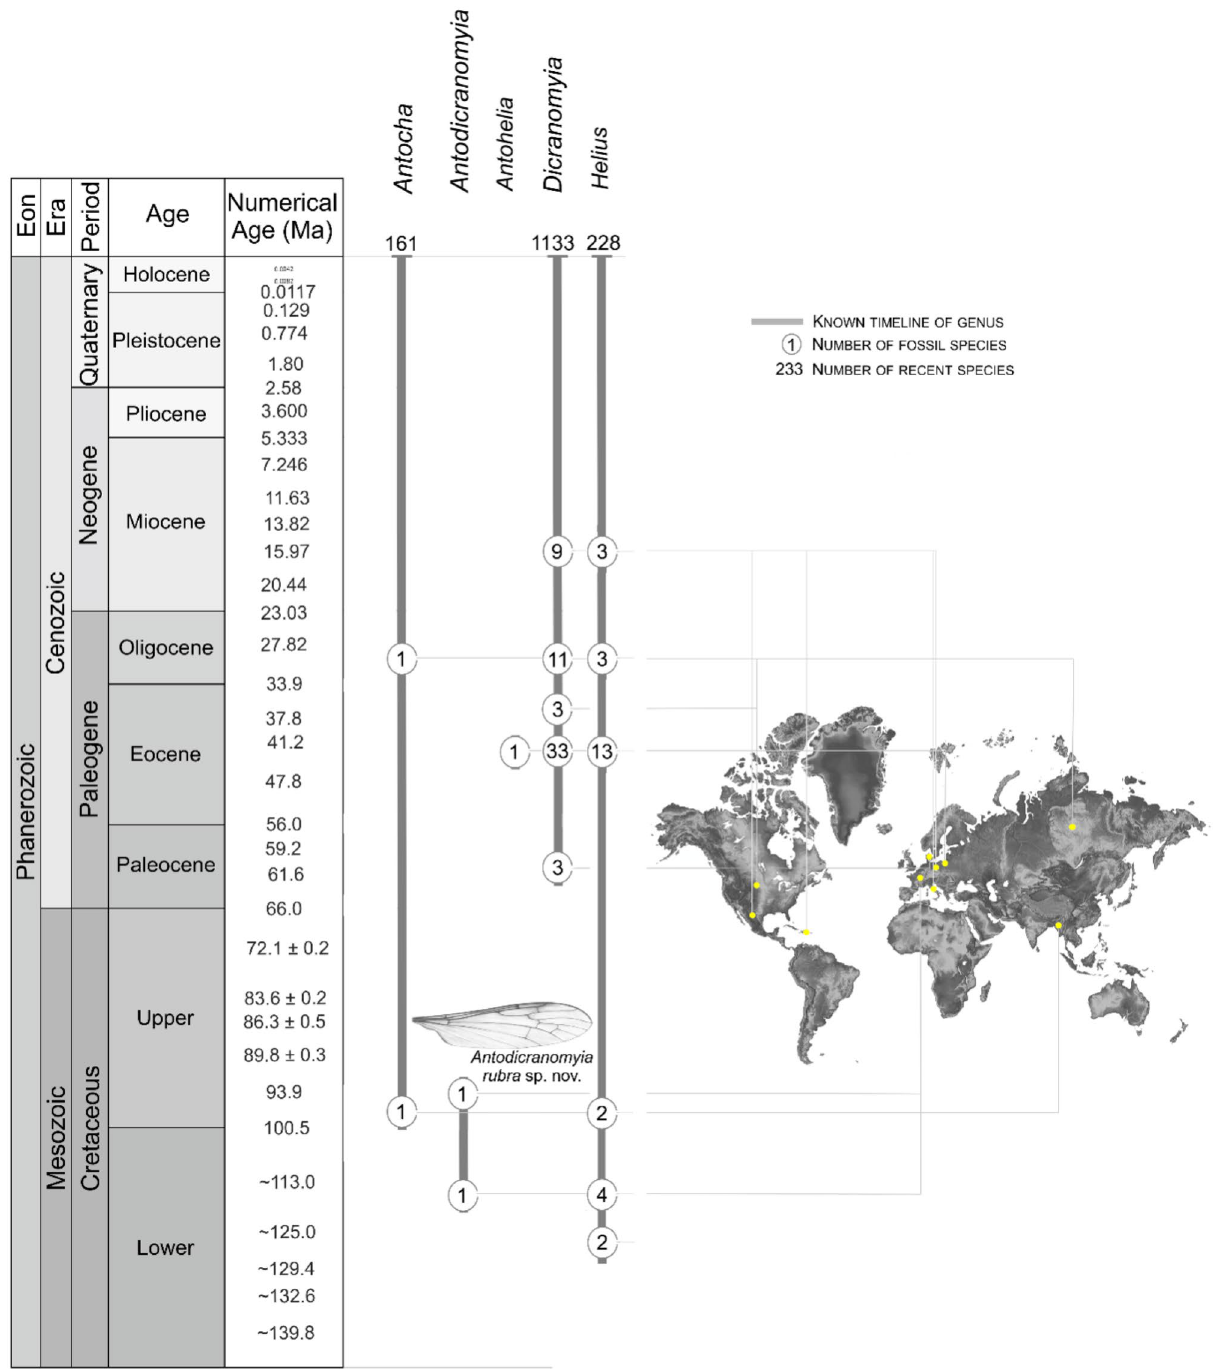
Figure 6. Chronostratigraphic distribution of Antocha , Antodicranomyia , Antohelia, Dicranomyia, Helius fossil species with chosen fossil sites localization. Stratigraphic chart according to International Stratigraphic Chart, International Commission of Stratigraphy (v. 2021/05) https:// strat igrap hy. org/ chart (accessed on 16 September